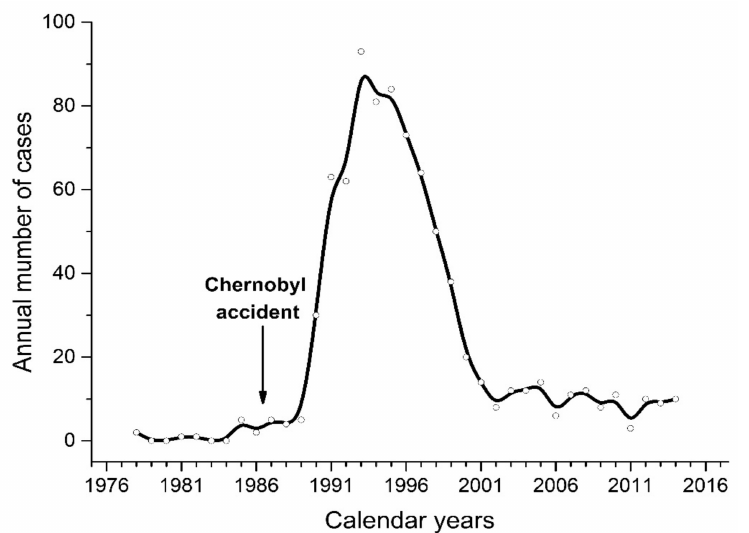
Figure 1. Number of cases of thyroid cancer in children aged 0–14 years in Belarus during 1978–2014. Data are retrieved from the database of Childhood Cancer SubRegistry of Belarus. Approximate population of children 0–14 years old was 1.57 million in